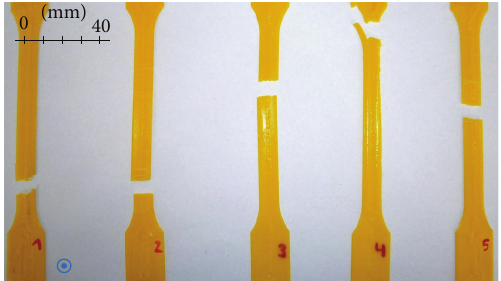
Figure 4: Fracture location on FLM dumbbell specimens (blue = build